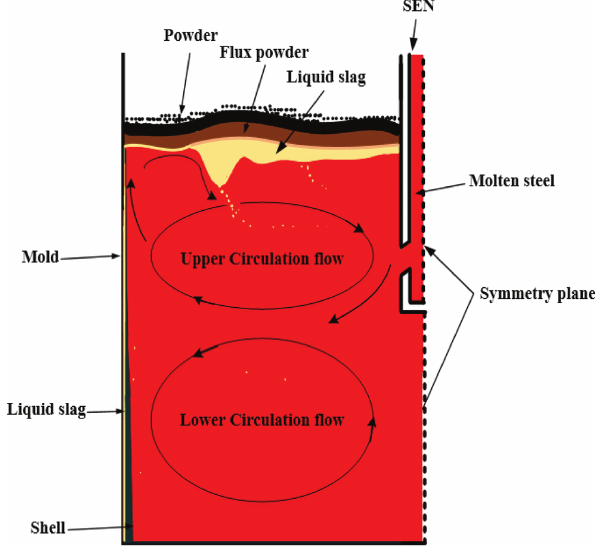
Figure 1: Schematic illustration of the liquid slag fluctuation and the slag